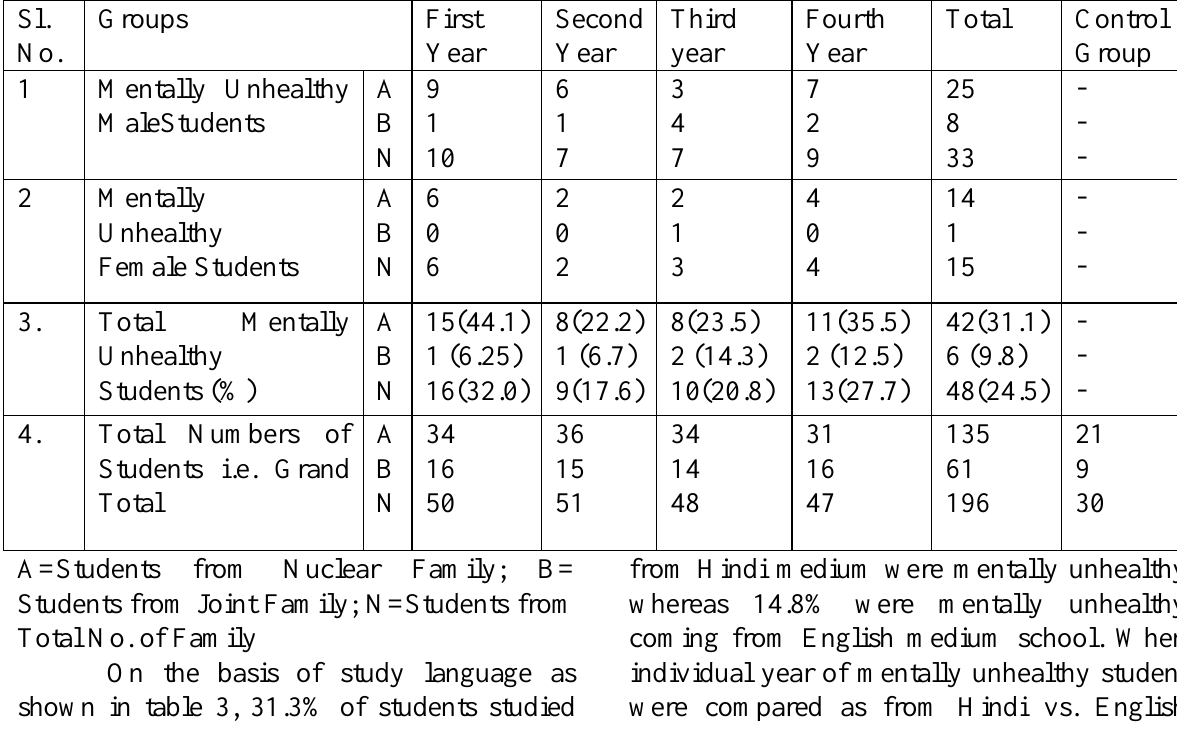
Table2. Distribution of Family type of Mentally Healthy and Unhealthy Engineering Students